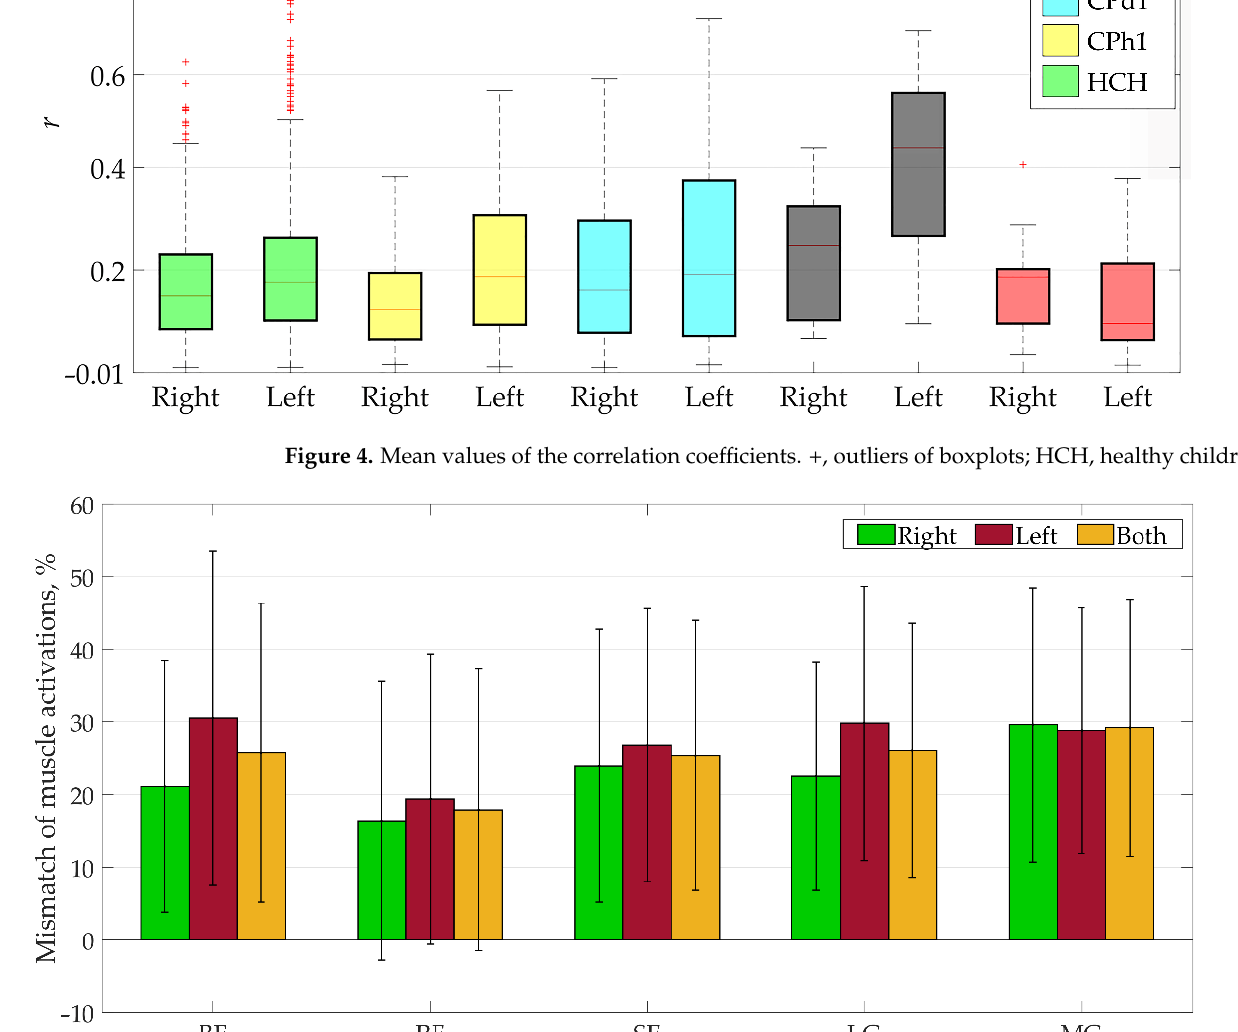
Figure 6 and Table A2 in Appendix A show the results of the activity overlap between